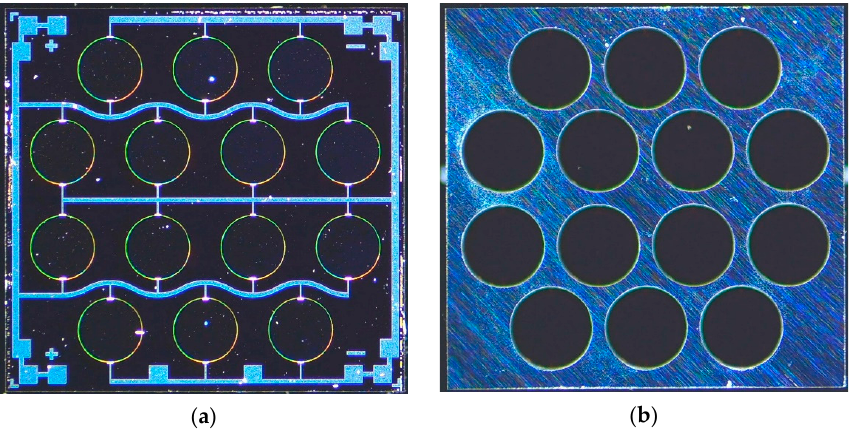
Figure 3. PMUT array optical image: ( a ) Front of PMUT array. The array is composed of 14 designed PMUTs; ( b ) Back of PMUT